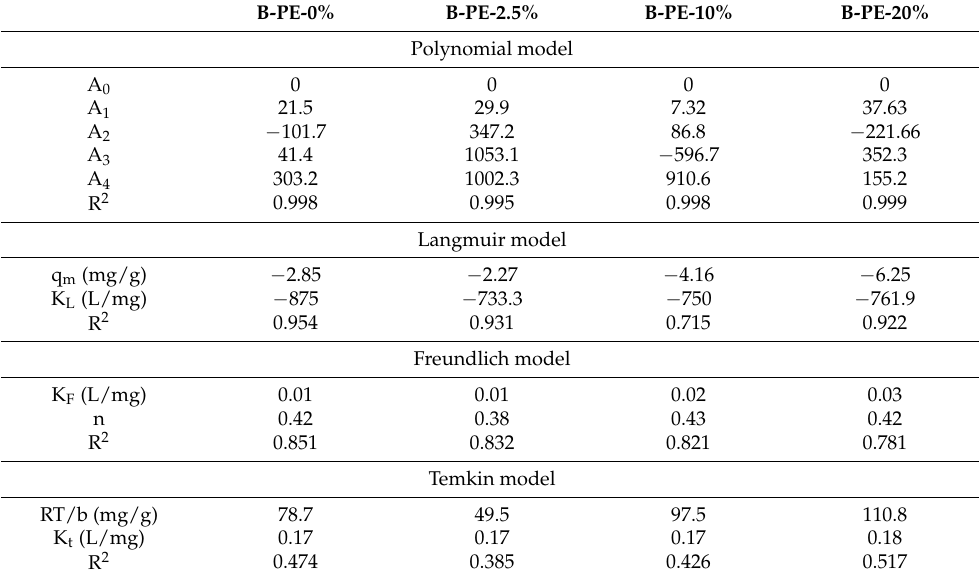
Table 3. Parameters obtained by fitting experimental sorption data with the proposed models.